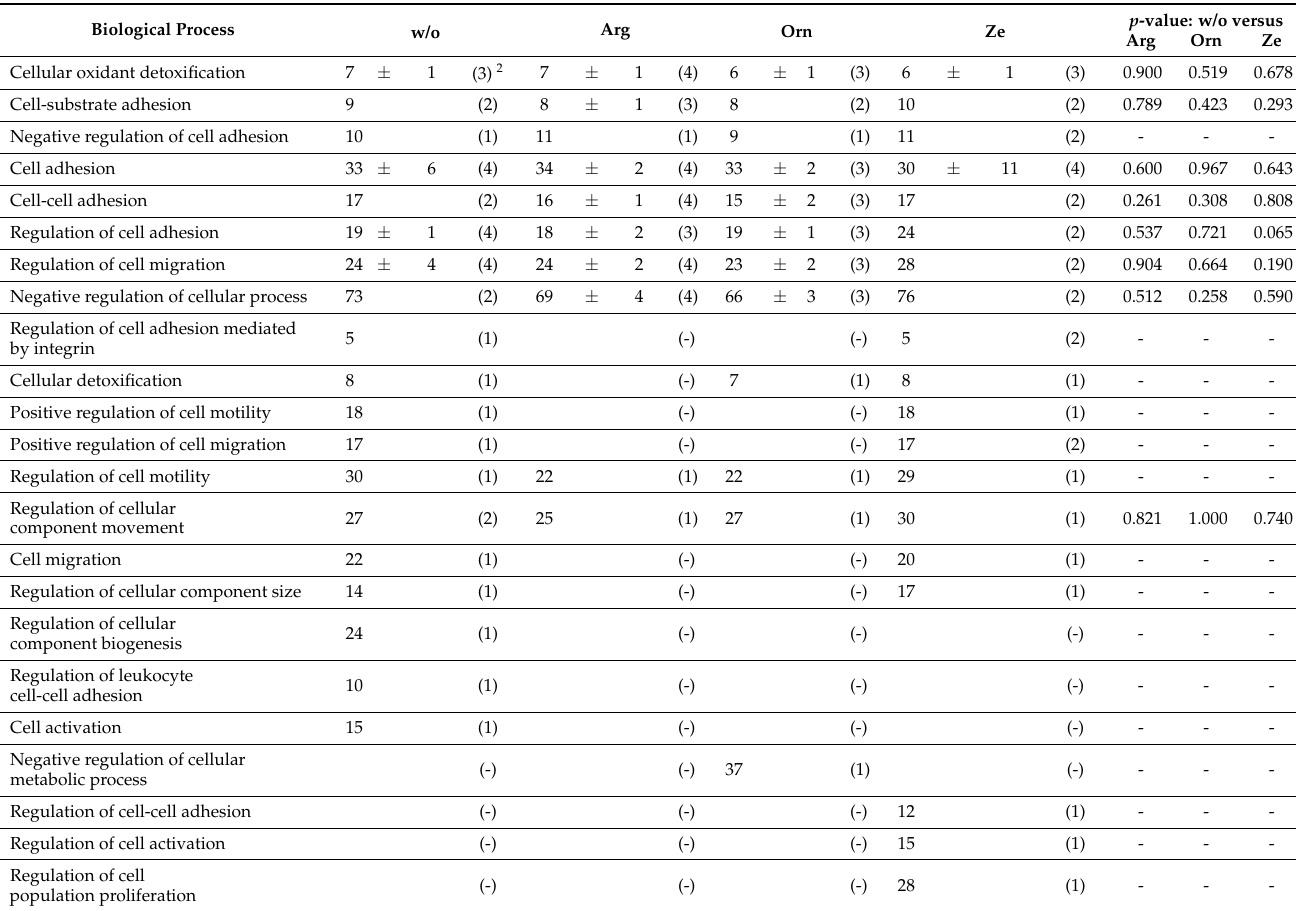
Table 2. Urinary proteins associated with biological processes 1 related to the cell communi- cation/activity, detected in the urine of cats ( n = 4) fed a high-protein diet without (w/o) or with the supplementation of arginine (Arg), ornithine (Orn) or zeolite (Ze). Mean number of proteins ± standard deviation.